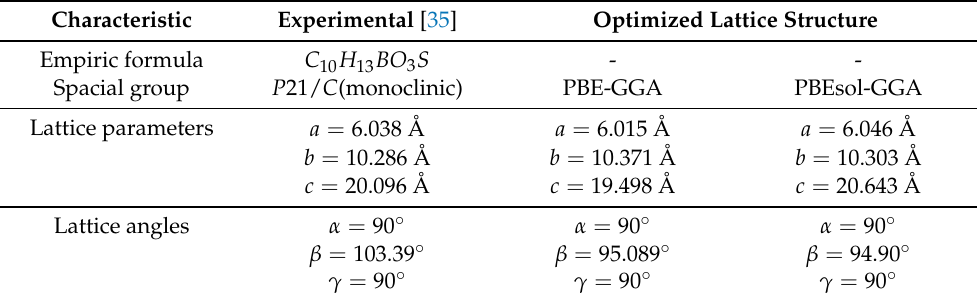
Figure 2. ( a ) Periodic structure. ( b ) Unitary cell of the C 10 H 13 BO 3 S structure. Table 1. Lattice parameters of the unitary cell of the C 10 H 13 BO 3 S